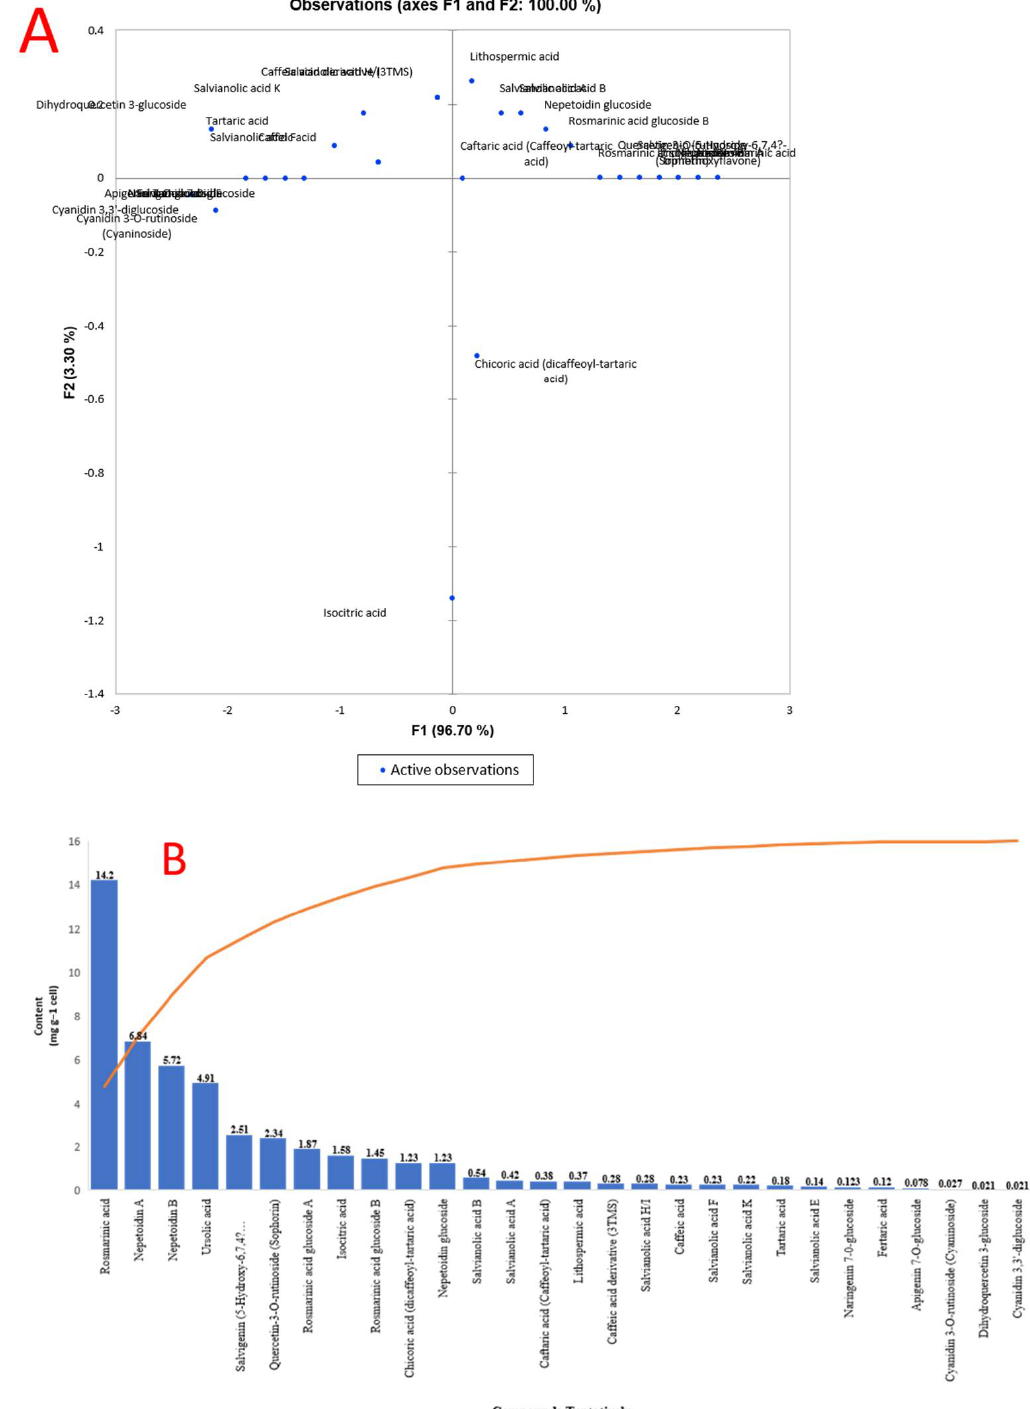
Figure 2. Analysis of the metabolite profiles of O. basilicum cell suspension extracts ( A ) principal component analysis (PCA) and ( B ) compounds tentatively and content of O. basilicum cell suspension extracts using LC-MS Chromatogram.